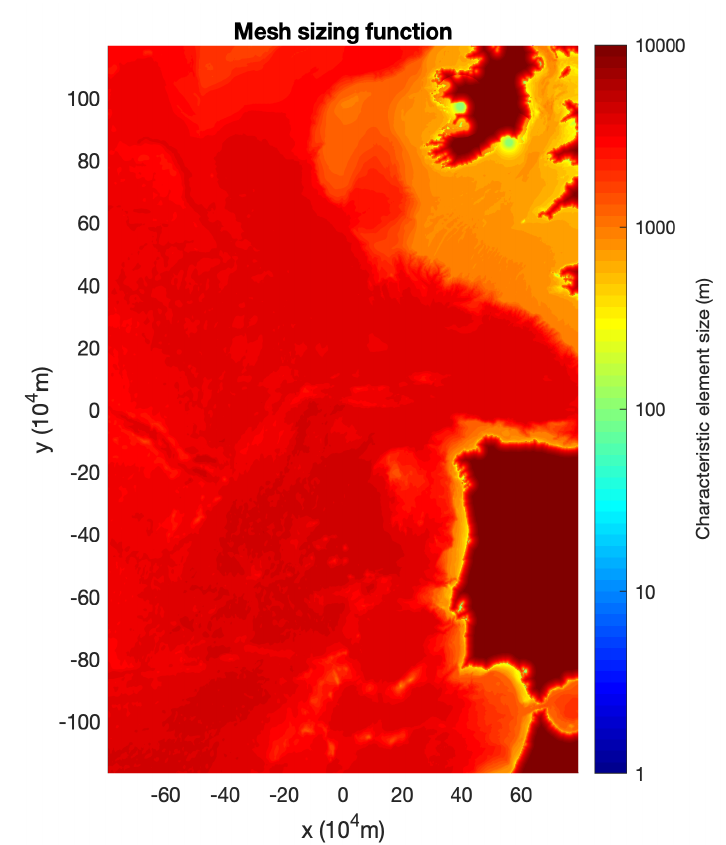
Figure 3. Non-uniform unstructured mesh which is refined near the coastlines and the areas of interest: Galway Bay and Dunmore East. The minimum mesh element size is set to 100 m and the mesh contains 4,001,884